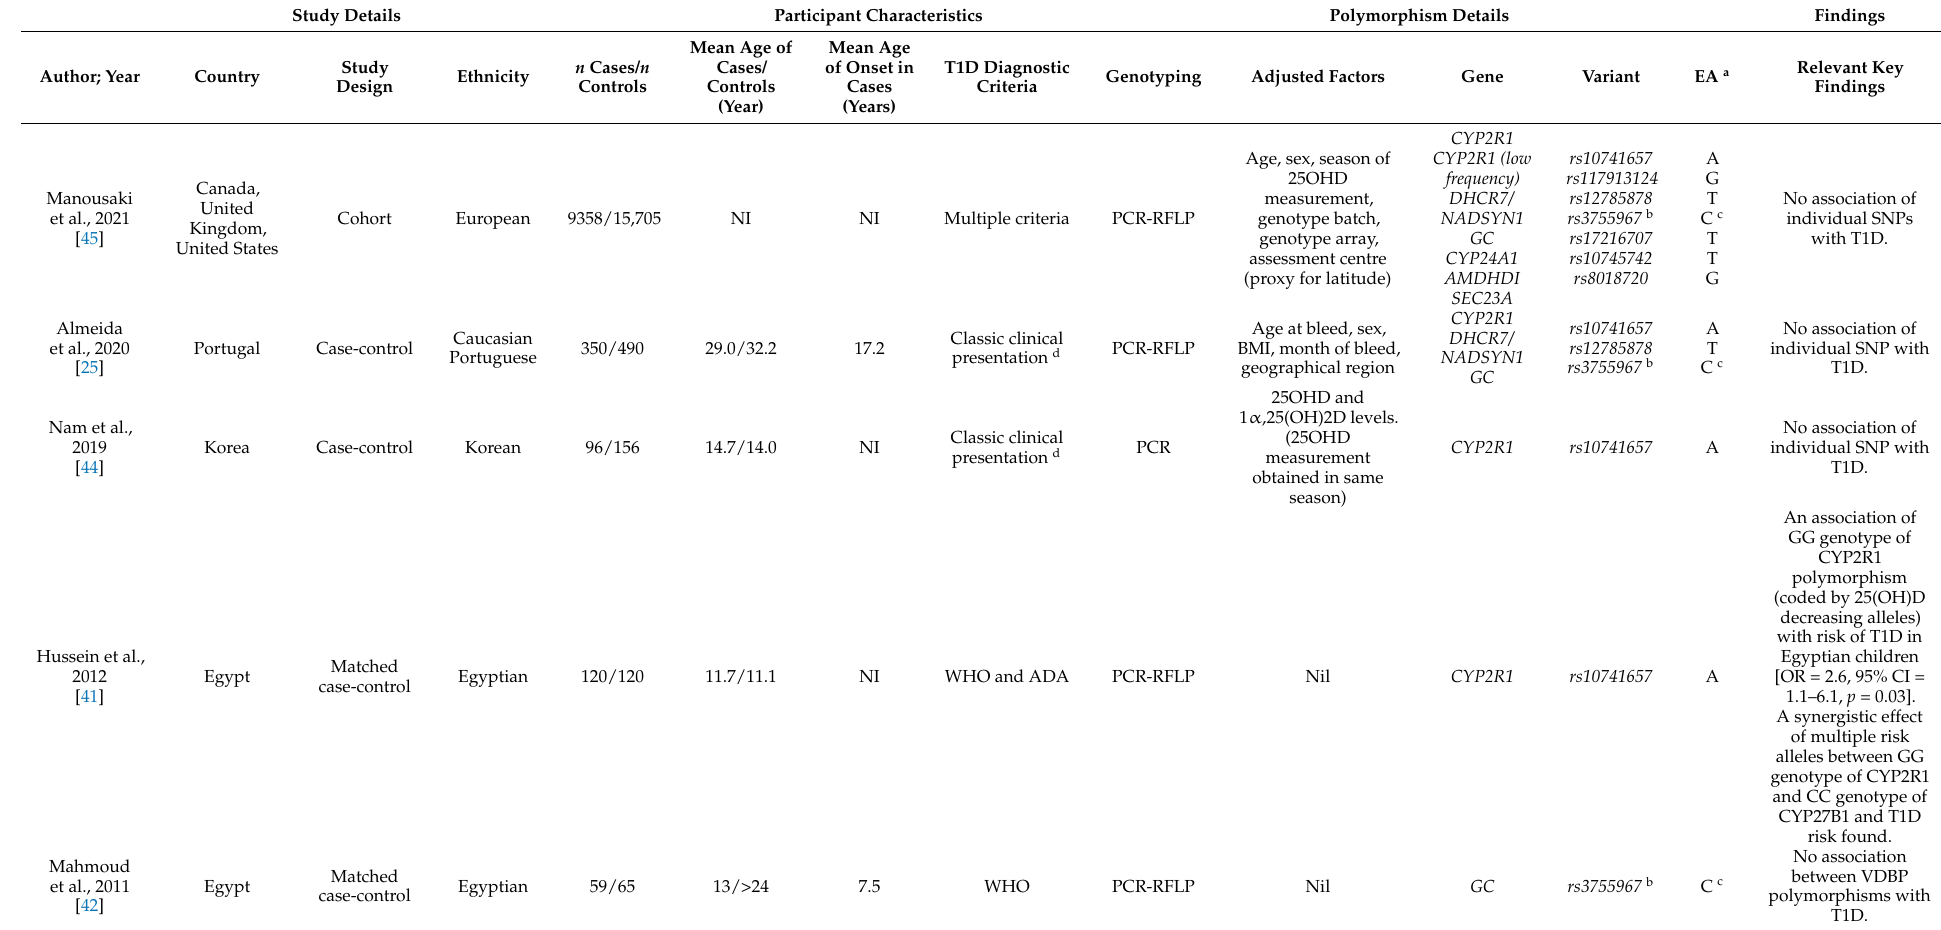
Table 1. Characteristics of observational studies evaluating the association between vitamin D genetic variants and type 1 diabetes included in the